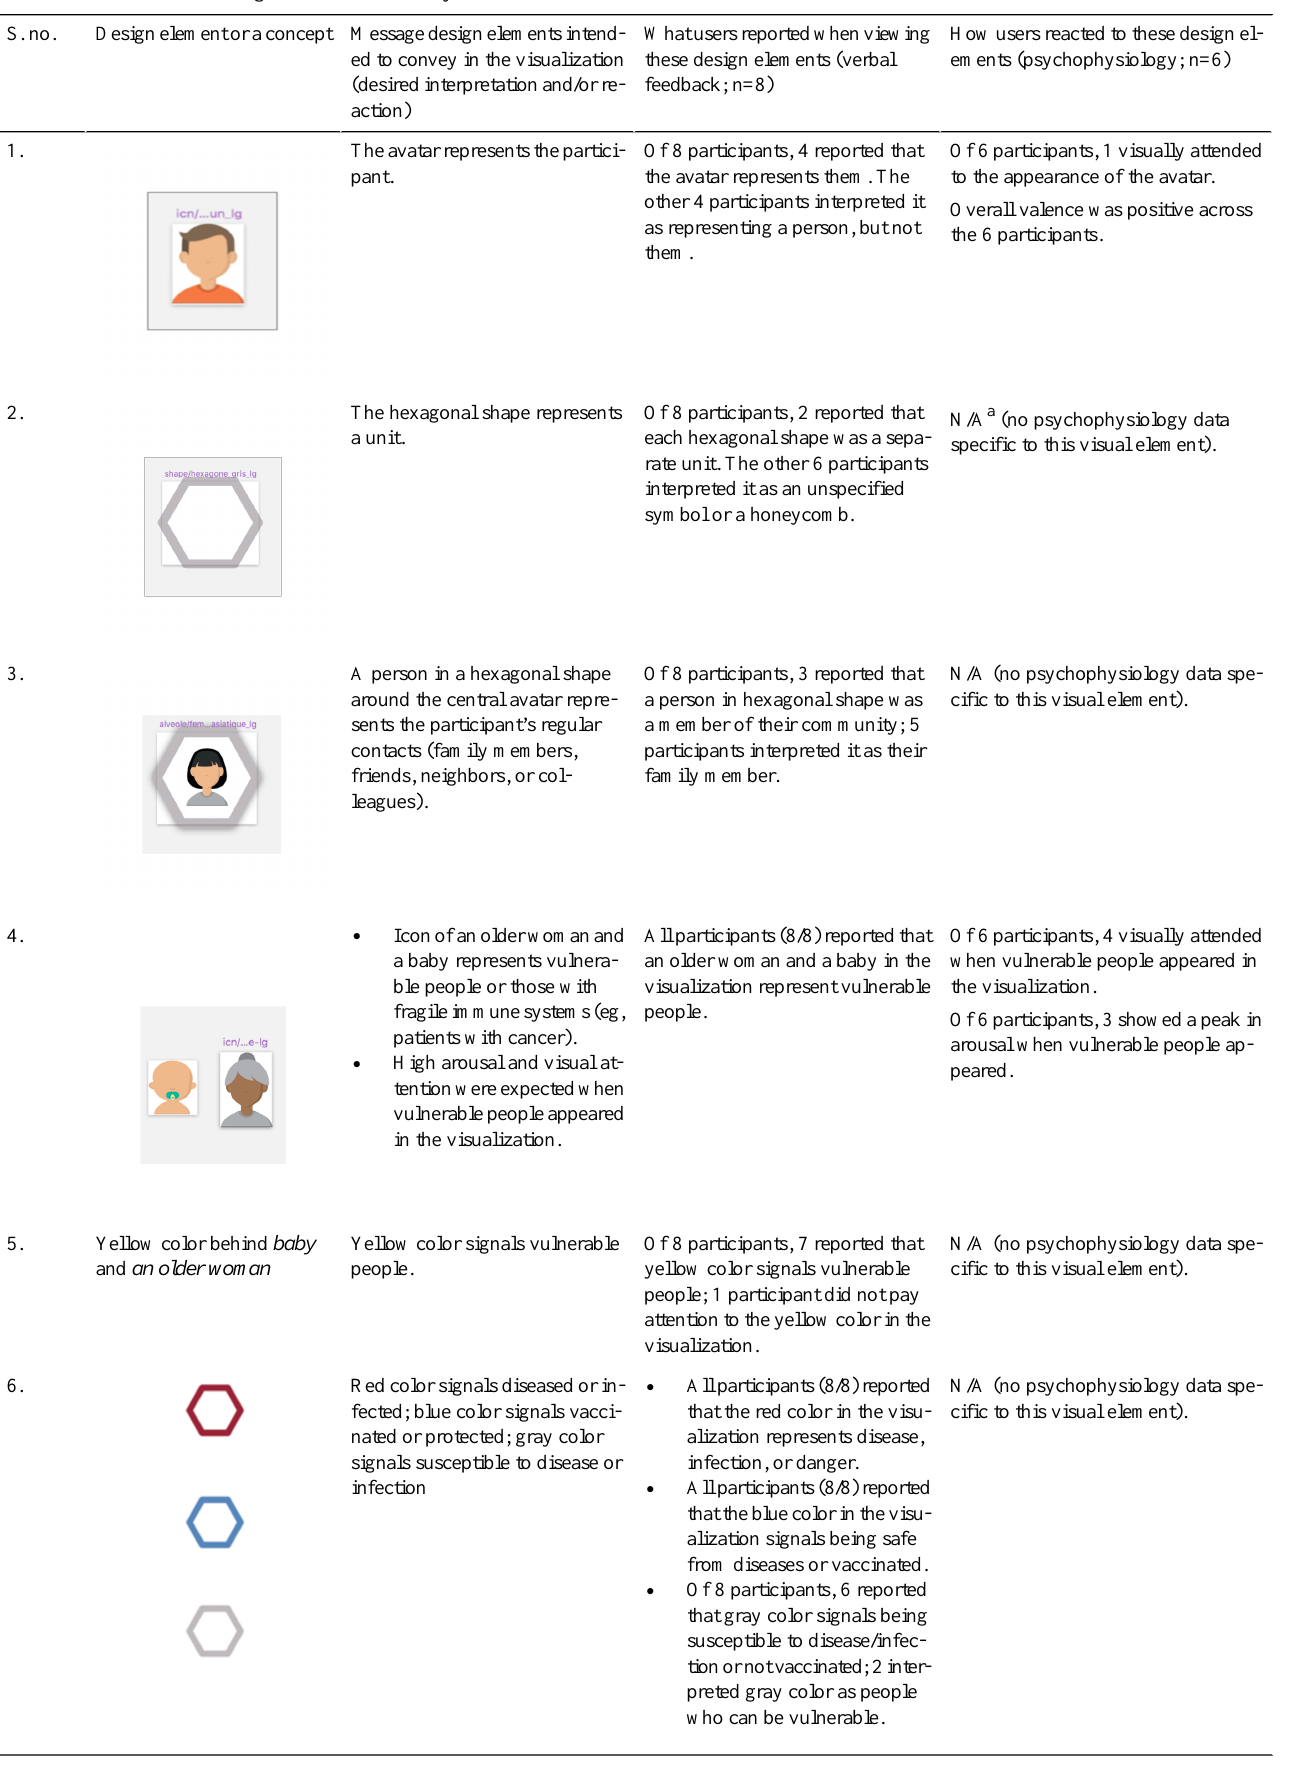
Table 3. The communication goals set for the first cycle of visualization.